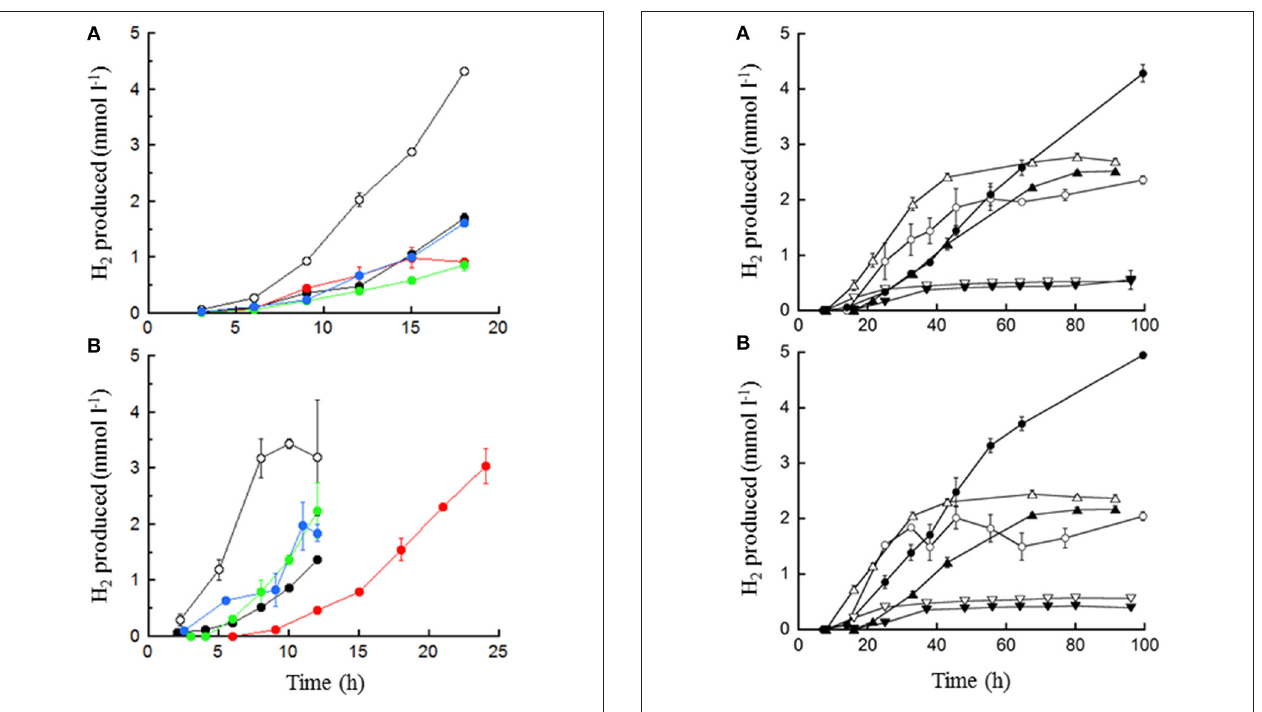
FIGURE 2 | H 2 production by T. paralvinellae (A) and P. furiosus (B) in ◦ 0.5% maltose ( ), 0.5% tryptone ( • ), 0.5% maltose + 0.05% tryptone ( • ), 0.5% maltose + 10mM acetate ( • ), and 0.5% maltose at pH 5.0 ( • ). Error bars represent the standard error. for both 0.1 and 10% waste milk ( Figure 3 ). T. paralvinellae